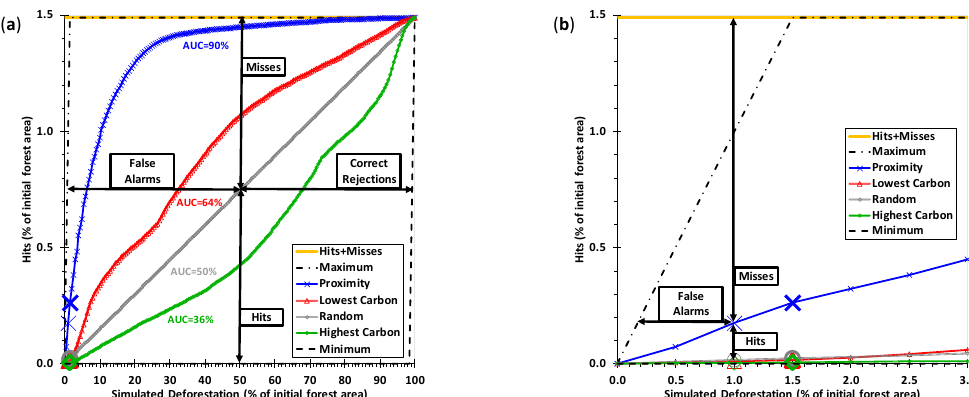
Figure 3. Total Operating Characteristic curves of four allocations at ( a ) full range and ( b ) zoomed in.